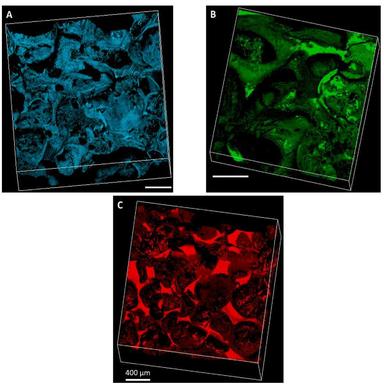
Confocal images of the etched epoxy pore cast of IL. The solid colours represent the pore space and the etched-away grains are black. Three samples were imaged with the 10X air objective lens, NA = 0.3. Sample (A) mixed with CascadeBlue dye (blue) and λExcitation = 405nm. Sample (B) mixed with Coumarin 6 dye (green) and λExcitation = 488nm. Sample (C) mixed with Rhodamine-B dye (red) and λExcitation = 561nm.